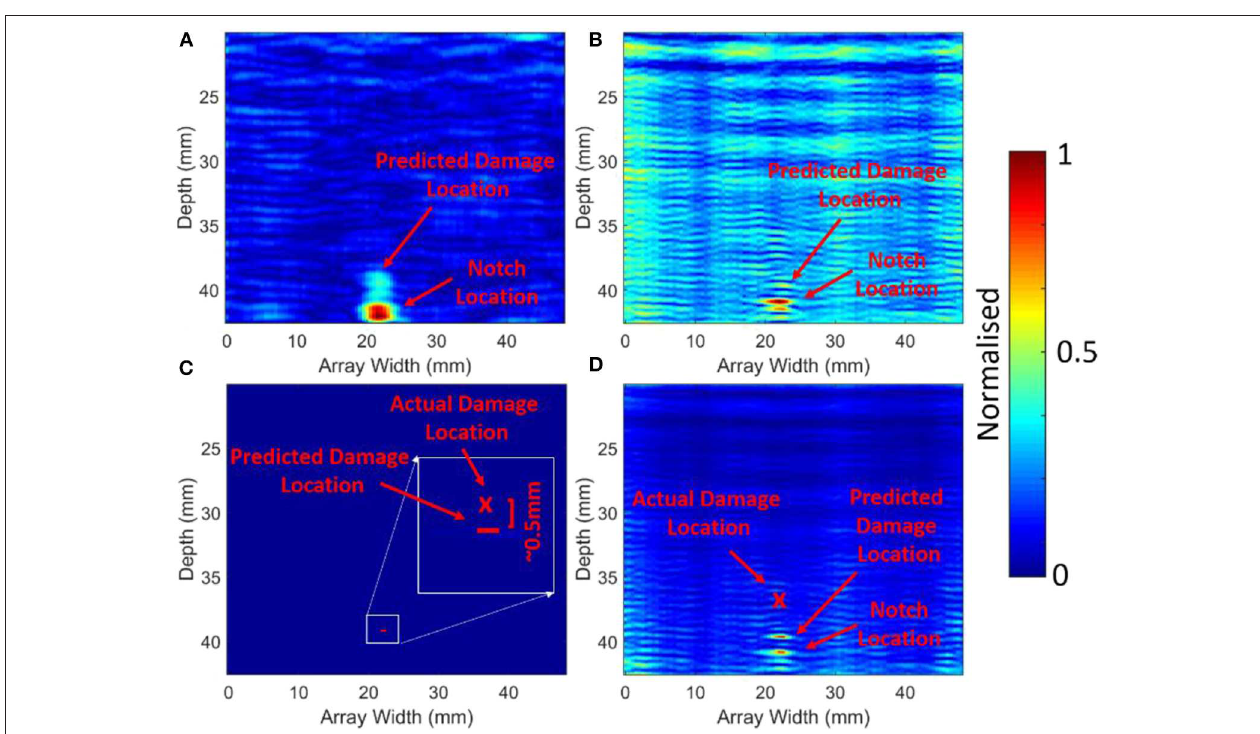
FIGURE 11 | SFC sample comparison of different frequency excitation signals for tri frequency modulation: (A) M R 3 for 3.8 & 4 & 4.2 MHz; (B) M R 3 for 5.8 & 6 & 6.2 MHz; (C) β TRI for 3.8 & 4 & 4.2 MHz; (D) β TRI for 5.8 & 6 & 6.2 MHz.